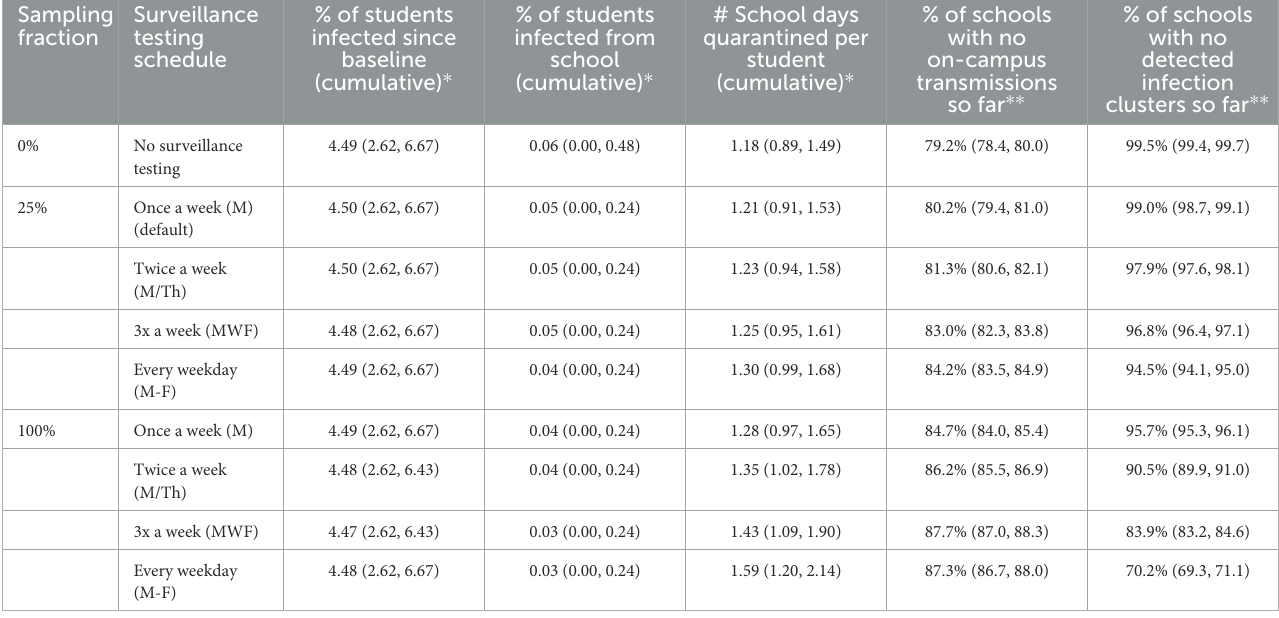
TABLE 2 Mean-average outcomes after 2 months of in-person instruction, by surveillance testing frequency and sampling fraction. Sampling fraction